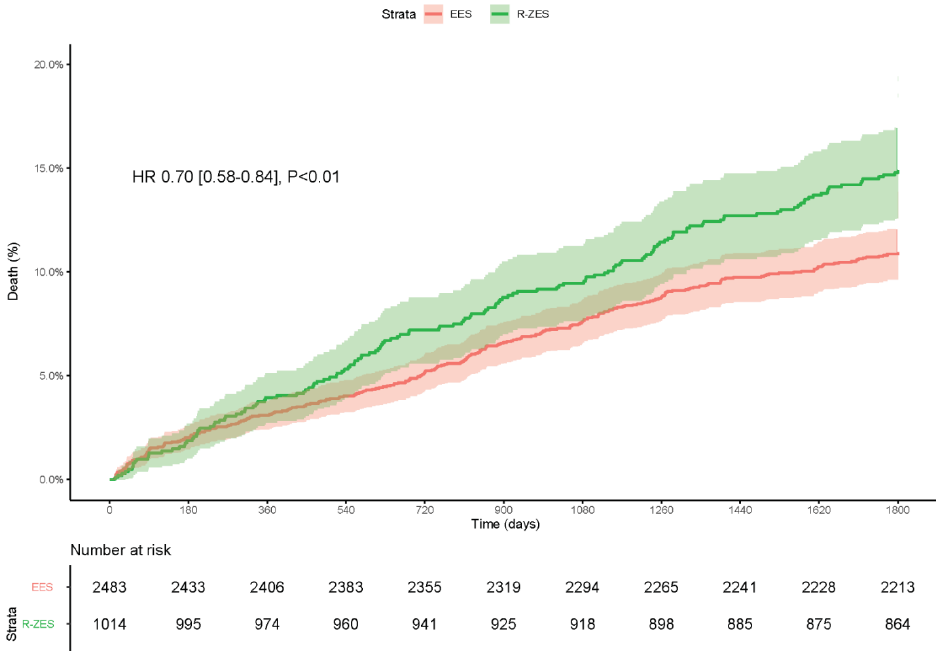
Figure 3. Kaplan–Meier graph of the cumulative incidence of mortality.